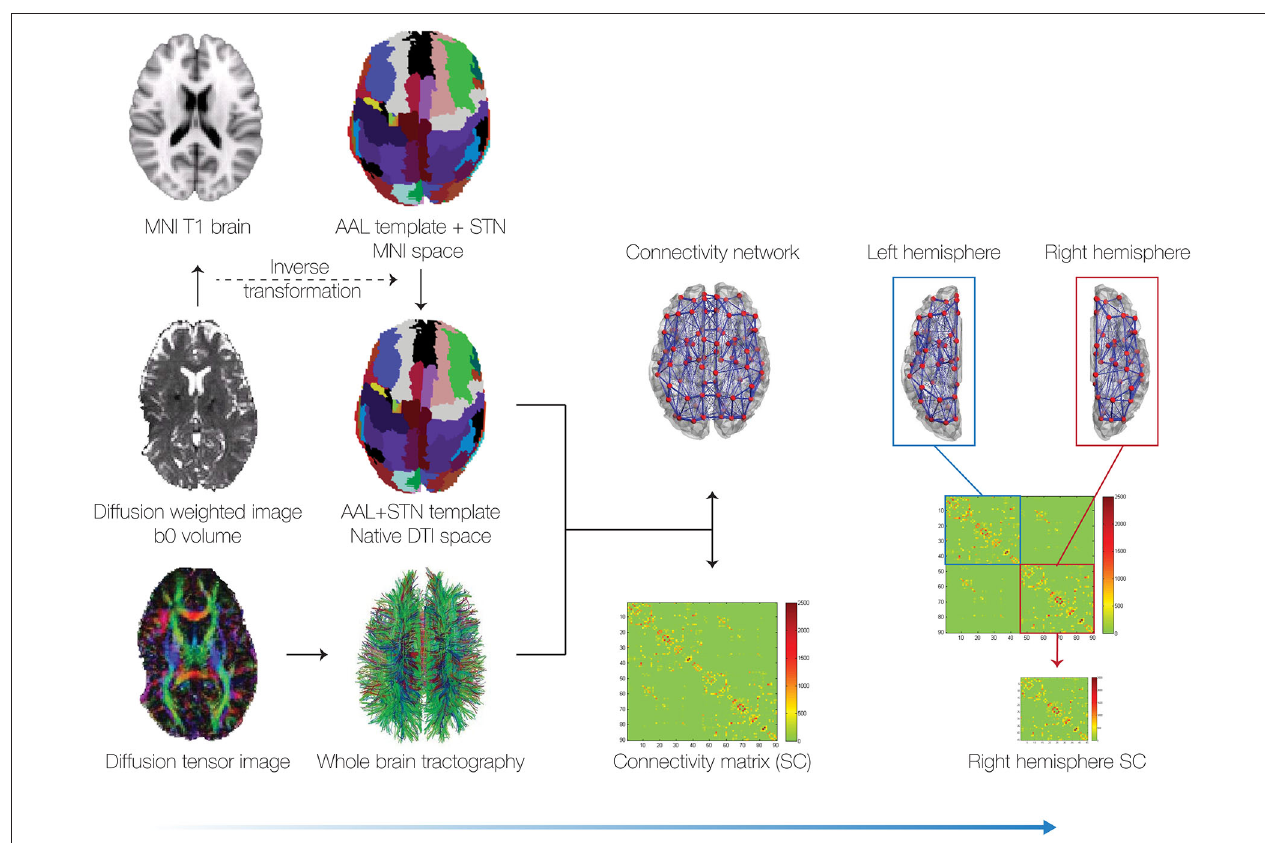
2012). This resulted in a total of 92 cortical and subcortical regions (46 per hemisphere). We reconstructed the whole-brain connectivity matrix between these 92 brain regions using the methods described in van Hartevelt et al. (2014). Due to the electrode artifact in the left hemisphere (see bottom left), in the subsequent analyses we only used the right hemisphere connectivity